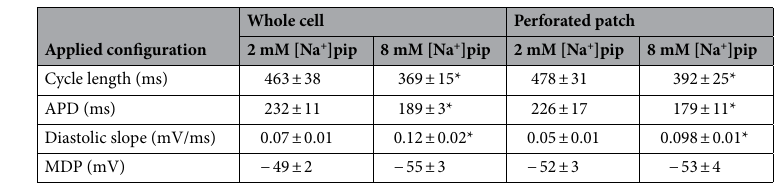
Table 1. Comparison of AP data measured by whole cell and perforated patch clamp configurations. *Indicate significant ( p < 0.05) differences between [Na] pip groups within the same configuration.